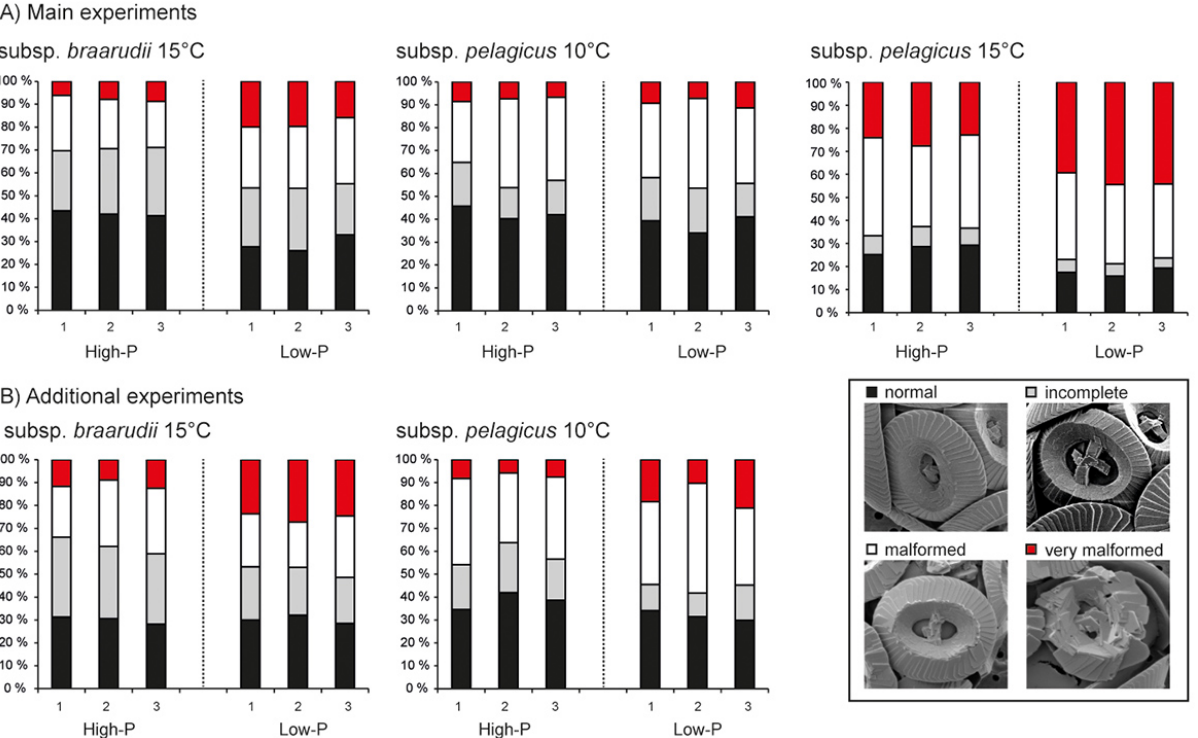
Figure 5. Morphology of coccoliths observed by scanning electron microscopy, shown as the percentage of four categories: normal (black), incomplete (grey), malformed (white) and very malformed (red). (A) Main experiments and (B) additional experiments of high-P and low-P cultures of Coccolithus pelagicus subsp. braarudii at 15 ◦ C and subsp. pelagicus at 10 and 15 ◦ C. Triplicate batch cultures (1, 2, 3) are presented separately for each